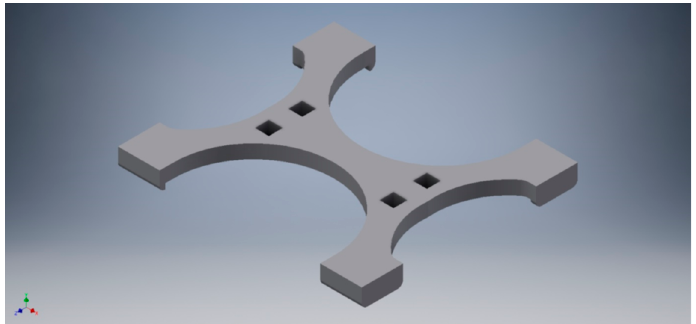
Figure 12. 3D rendering of the assembly between a coin compartment and the workpiece designed for the union between compartments and load cells.